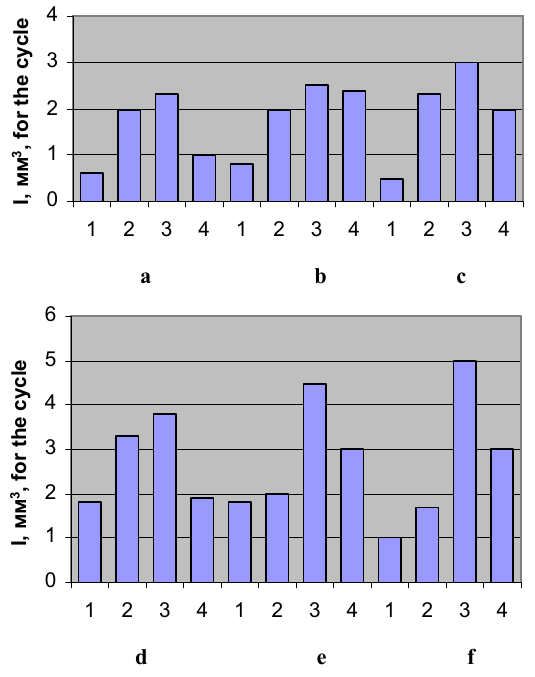
Fig 6. Diagrams of volume wear of the materials under study in different atmospheric gases (1 - nitrogen; 2 - air, 3 - oxygen, 4 - carbon dioxide by V=38 m/s, A=0,5 mm) a- ЭП -367; b- ЭИ - 893; с - Ж C6K; d- И -625; e-steel X18H10T; f-steel 45